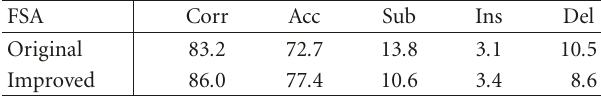
Table 6: Word recognition/error rate [%].